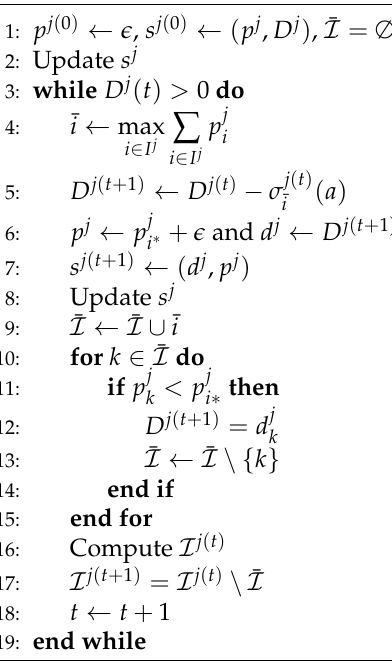
Algorithm 3 Seller progressive